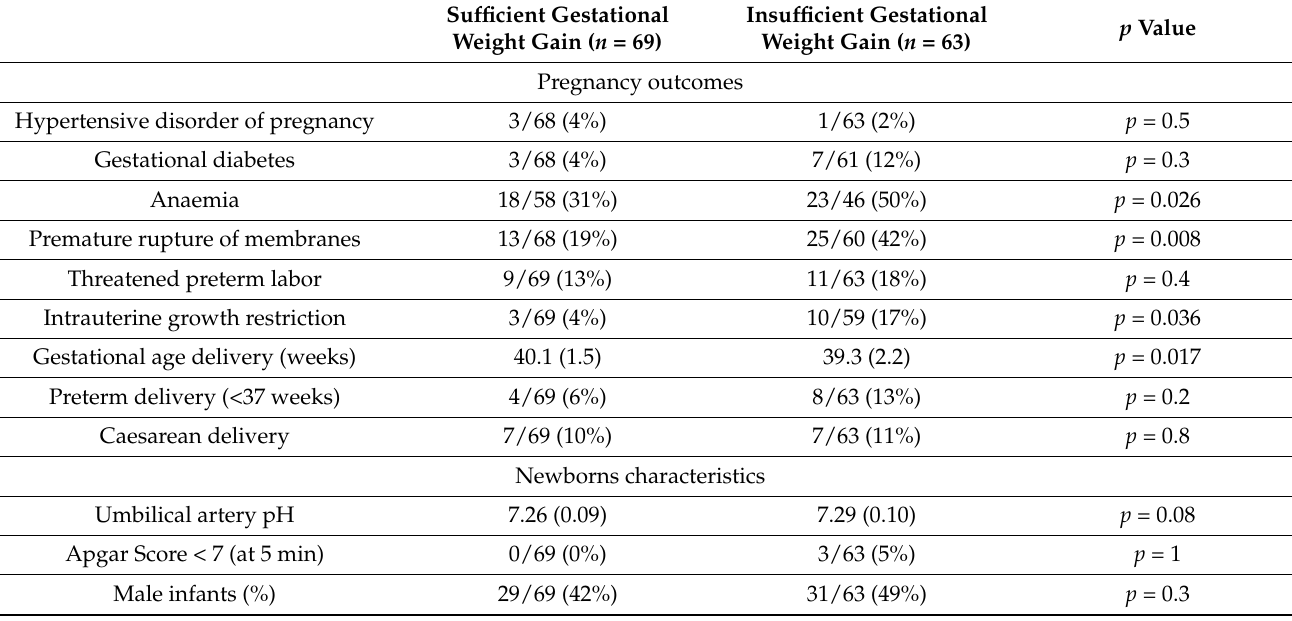
Table 2. Obstetric and neonatal outcomes in median (IQR) or in number (frequency) according to